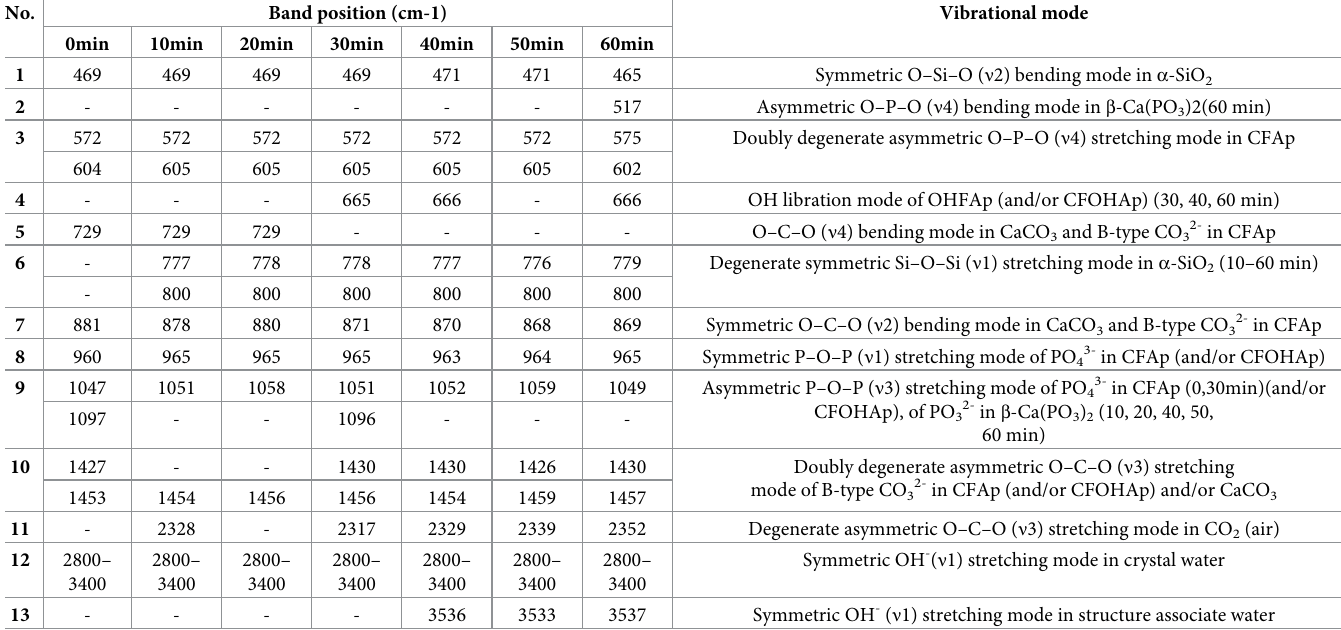
Table 1. The main characteristics of IR absorption bands of apatite with different milling time.